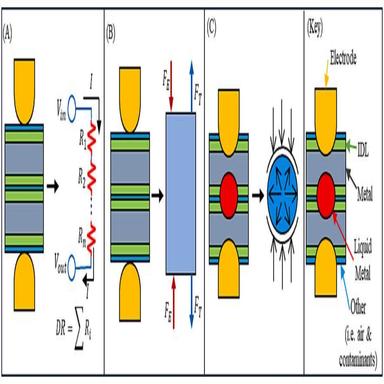
Illustration of physical mechanisms involved in RSW: (A) equivalent circuit diagram, (B) static model, (C) pressure diagram, and (Key) key to colors used in welding illustrations.